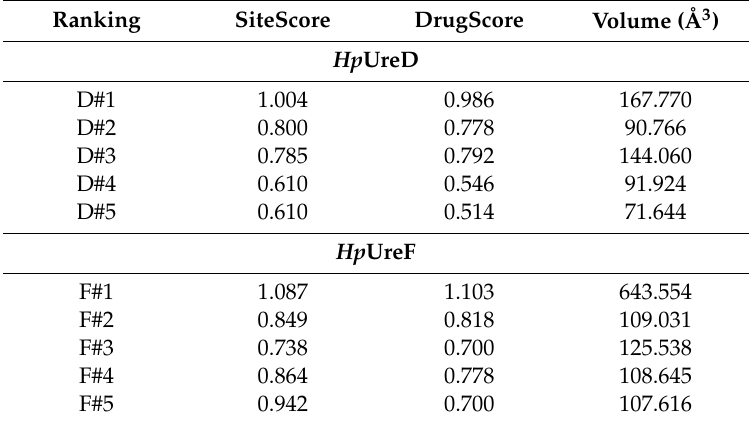
Table 1. Ranking of druggable sites at the surface of the Hp UreD monomer and the Hp (UreF) 2 dimer.